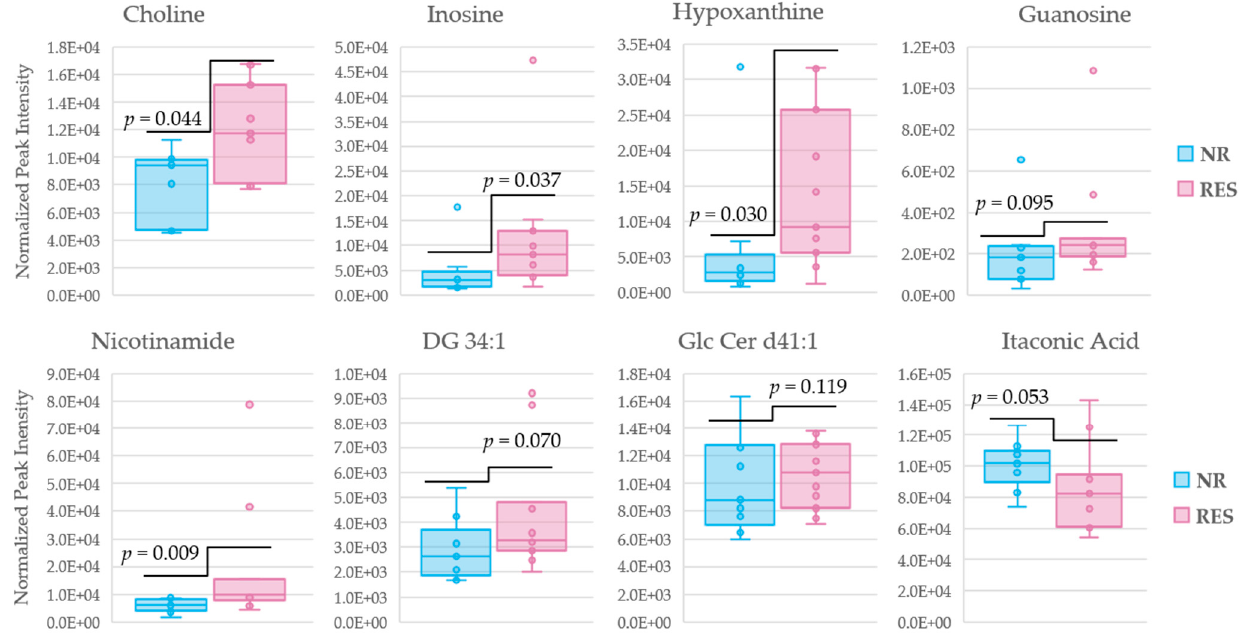
Figure 7. Box and whisker plots of metabolite levels after 16 weeks of MTX therapy distinguishing non-responders and responders according to a δ DAS ( − 1.2), representing a lowering in disease activity score of 1.2. The log normalized peak intensities for the eight metabolites identified by AUC analysis. Non-responders (blue); responders (red); diglyceride (DG); glucosylceramide (GlcCer).